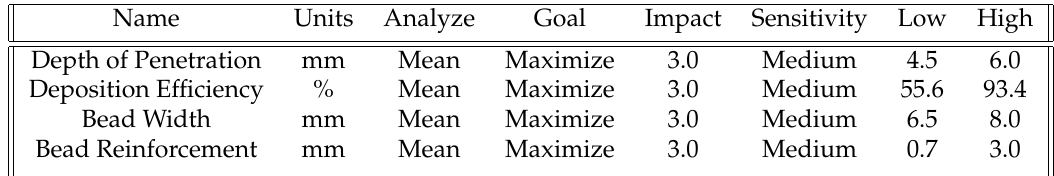
Table 2. Defining of responses to be varied